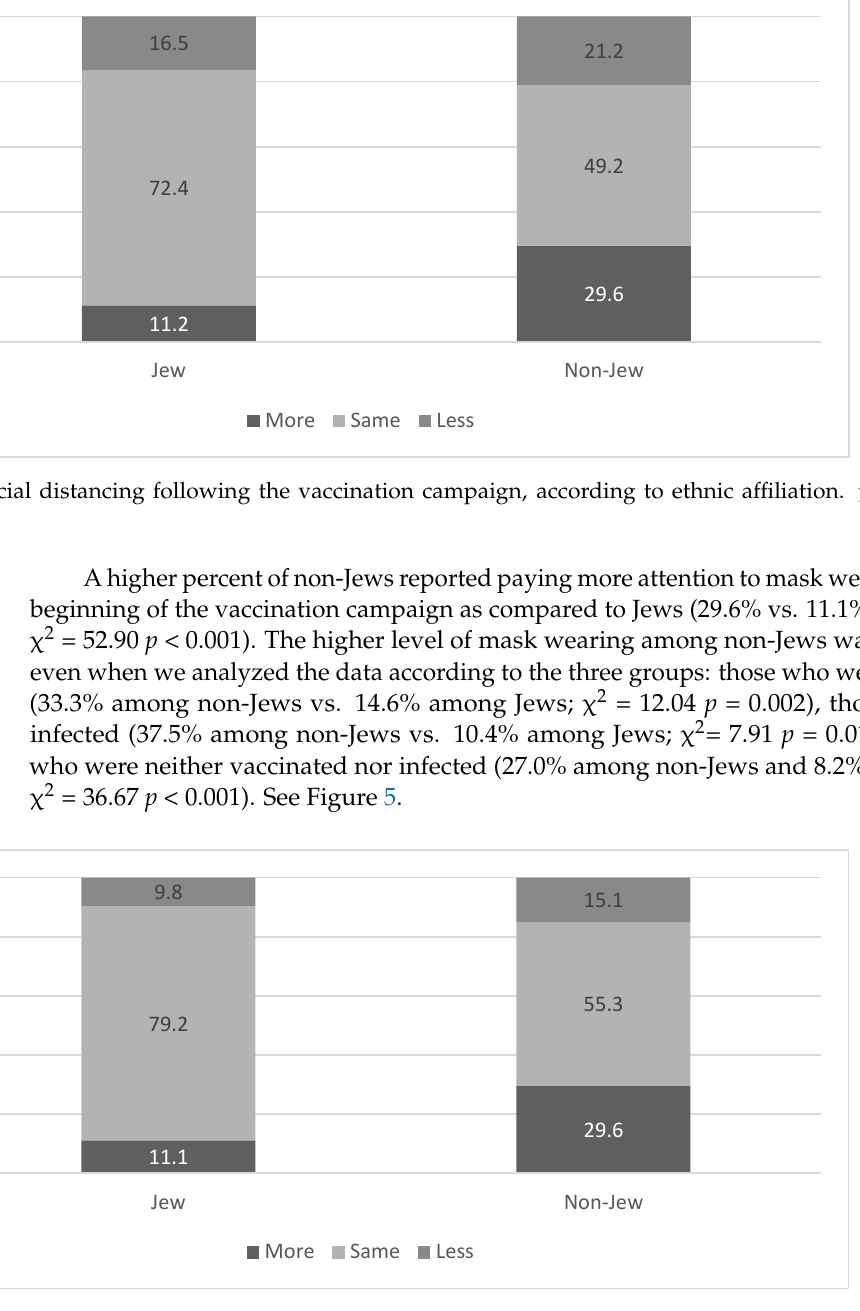
Figure 5. Change in mask-wearing following the vaccination campaign, according to ethnic affiliation. χ 2 = 52.90 p < 0.001.